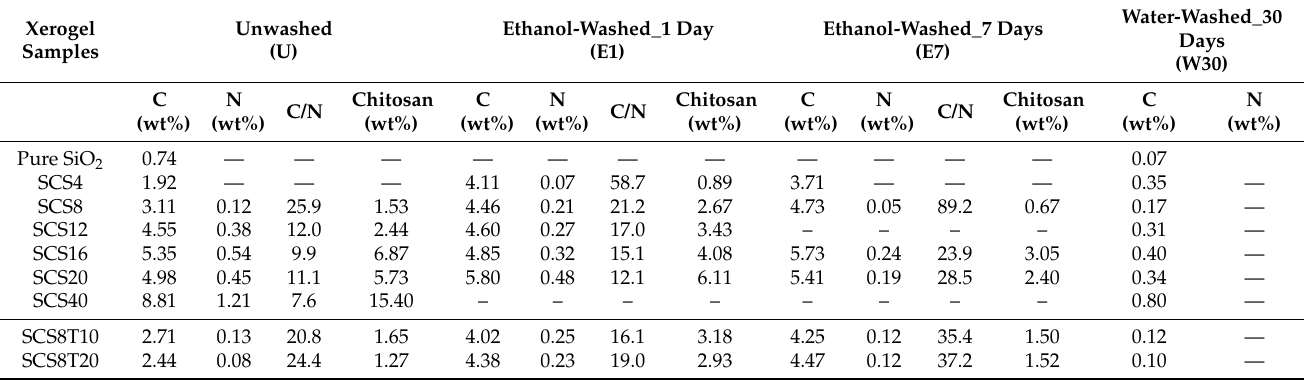
The real CS content was calculated from the N value measurements in EA, considering that chitosan is the unique source of nitrogen in the samples. Standard deviation was less than